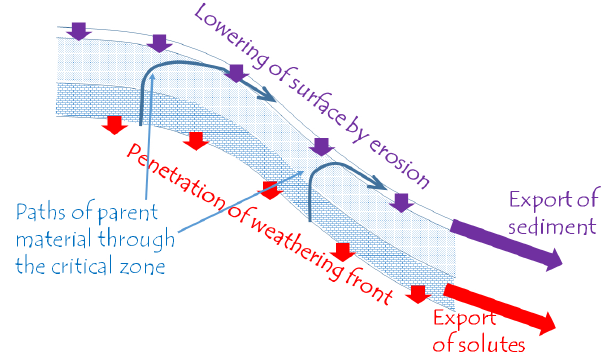
Figure 5. Paths of parent material as it progressively weathers and is carried away as sediment at and near the soil surface. If a steady state develops over time, the rate of surface lowering will be equal to the rate at which the weathering front penetrates into bedrock. 3 Water as a transporting medium in the critical